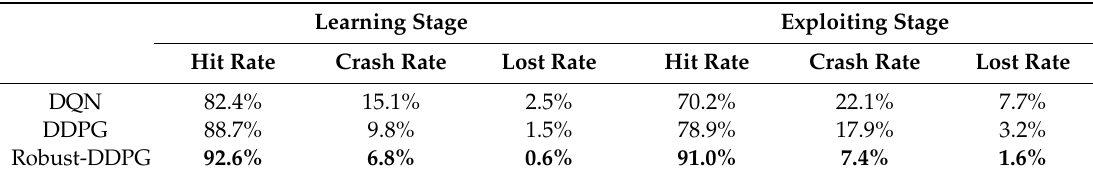
Table 1. The overall results of